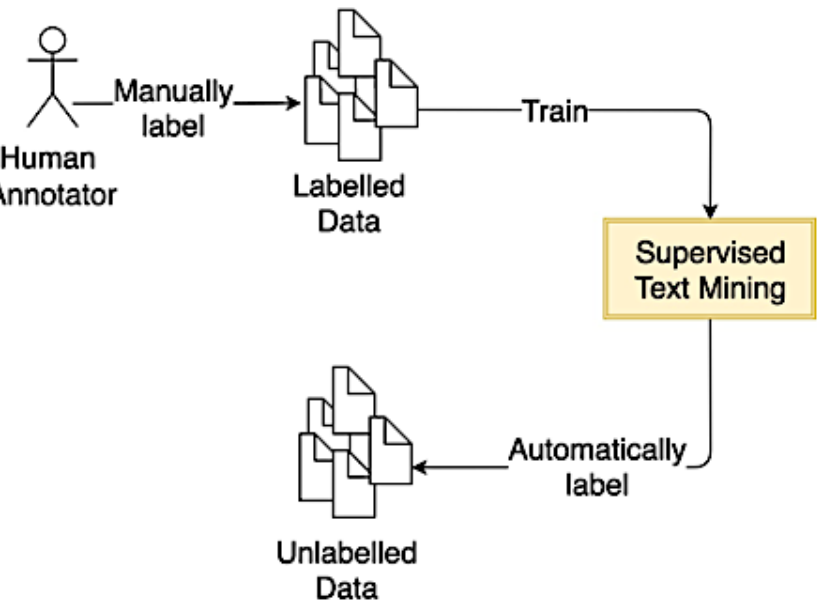
Figure 1. High-level overview of a supervised text-mining approach.